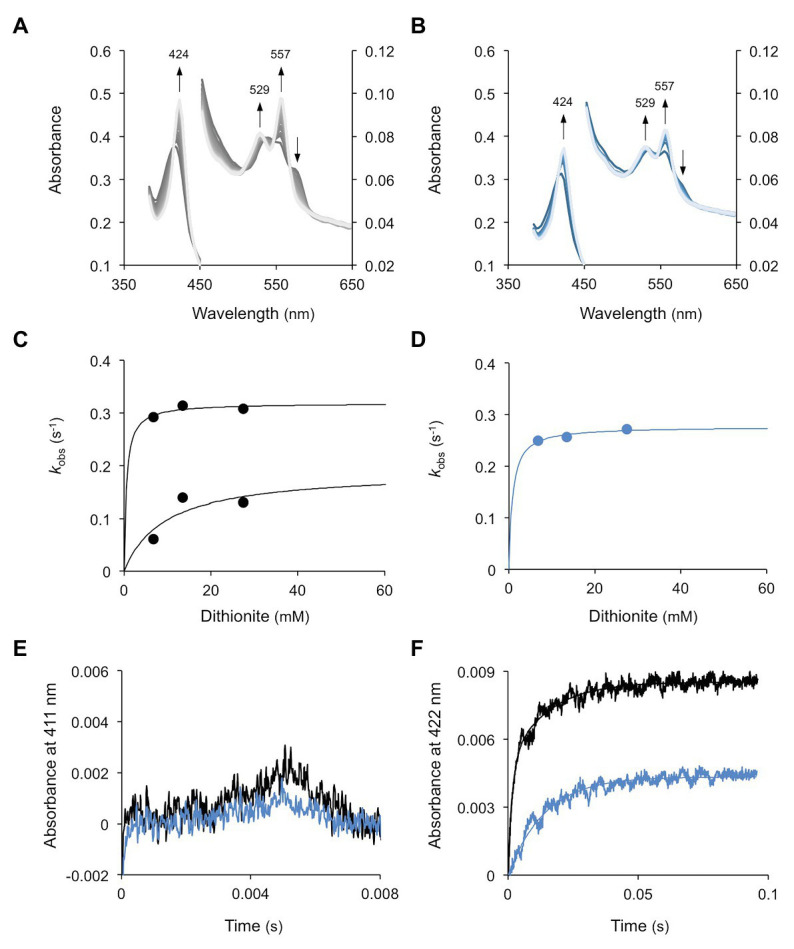
Dissociation and rebinding of O2 in WT1 and WT4. (A) Oxyferrous WT1 was mixed with dithionite and spectra were taken every 200 ms. Measurements were made in triplicate for each of the three concentrations of dithionite (6.75, 13.5, and 27.5 mM) and were fitted to a hyperbola function to obtain the maximum koff(O2). (B) Similar experiments for WT4, but spectra were taken every 400 ms. (C,D) Oxygen dissociation kinetics, where two phases and a single phase were observed, respectively, for (C) WT1 and (D) WT4. Pseudo first order constants were plotted as a function of exogenous dithionite concentration. (E) LFP kinetics of the oxyferrous forms of WT1 (black) and WT4 (blue). (F) LFP kinetics of the carboxy forms of WT1 (black) and WT4 (blue) showing double and single exponential kinetics, respectively. The CO concentration was 500 μM. All experiments were performed at 25°C.